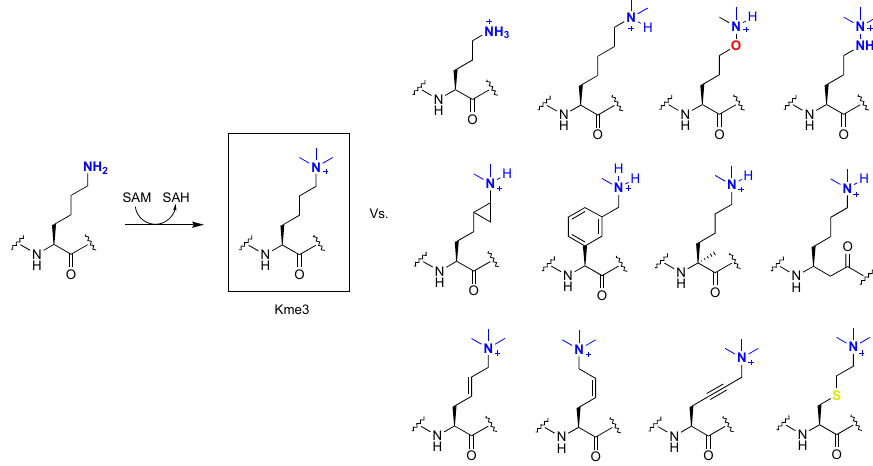
Figure 8. Kme3 analogues produced by histone lysine methyltransferases G9a and GLP.